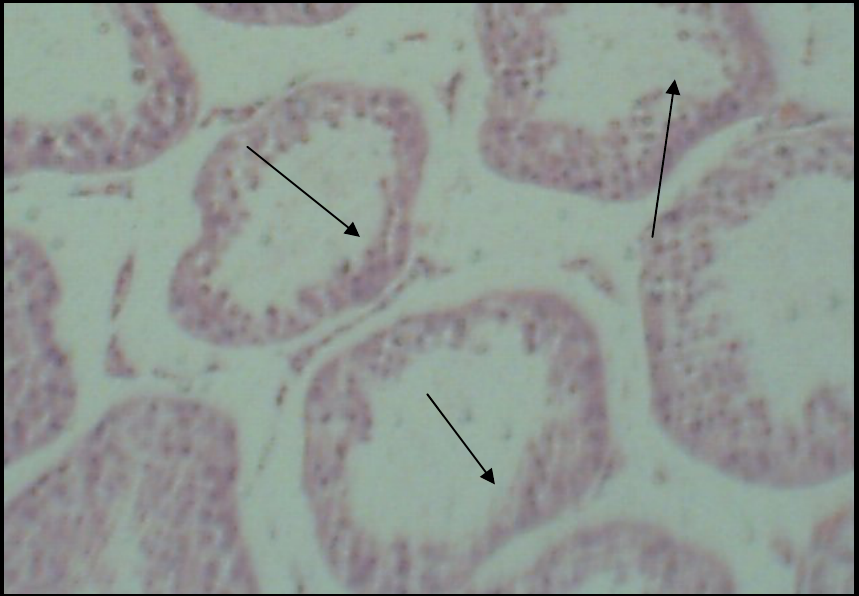
FIGURE 3 - Photomicrography of an adult hamster seminiferous tubules after treatement with finasteride. Remarcable seminiferous tubules atrophy (arrows) (HE